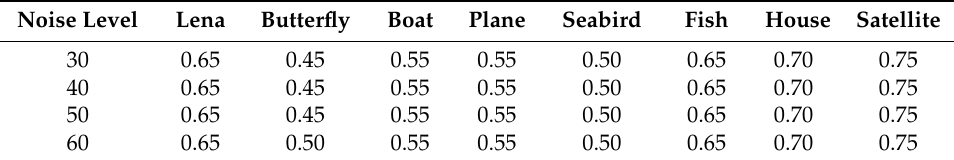
p Table 1. The p value that optimizes PSNR for different Table 1. The value that optimizes PSNR for different images.